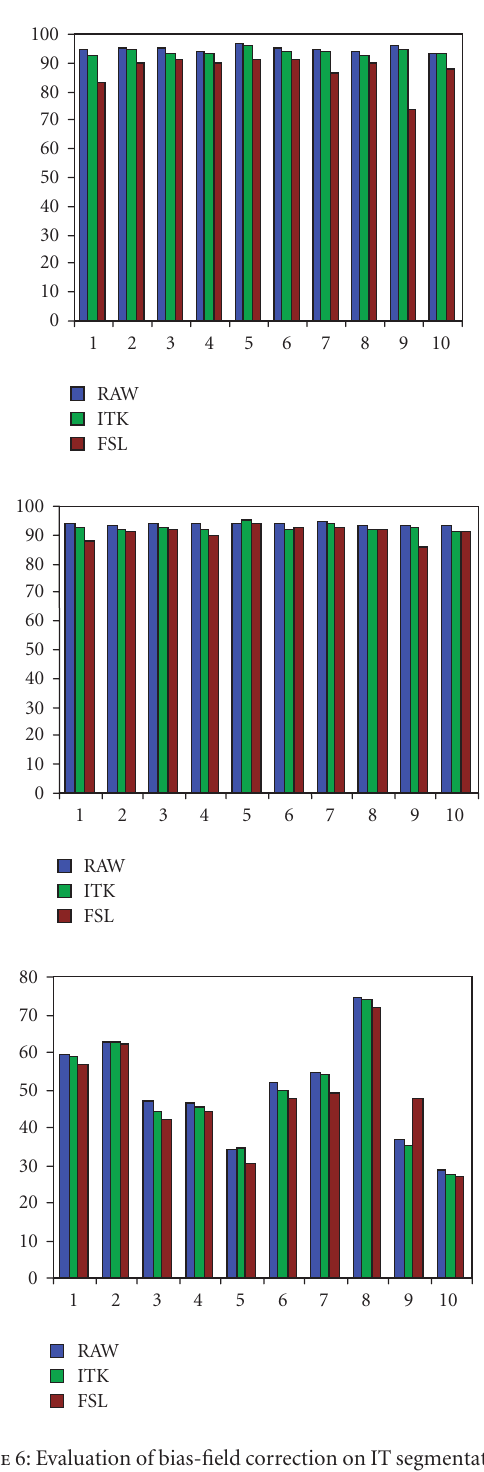
Figure 6: Evaluation of bias-field correction on IT segmentation on the 10 MRI cases. Bar plots of TPVF of (top) GM, (middle) WM, (bottom)